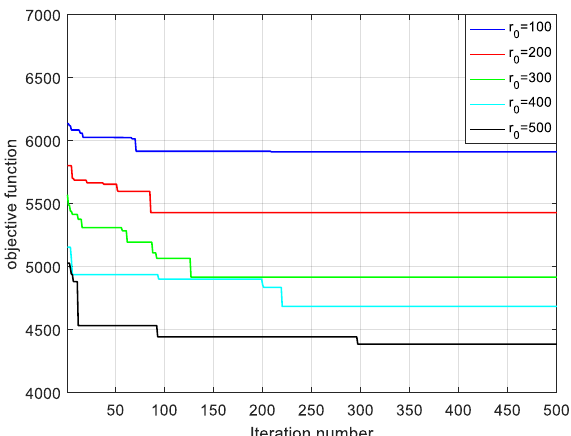
Figure 2. The Iterative process of the Ant Colony Algorithm (ACA).